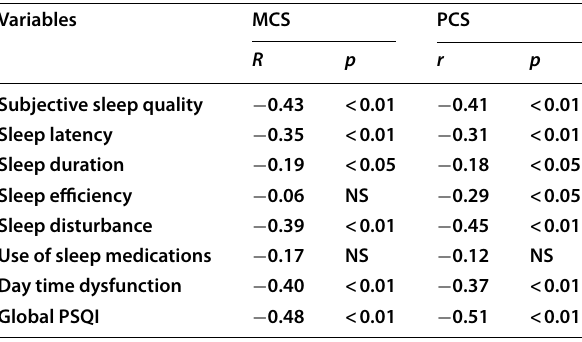
Table 5 Correlation coefficients for the SF 36 and the PSQI among perinatal